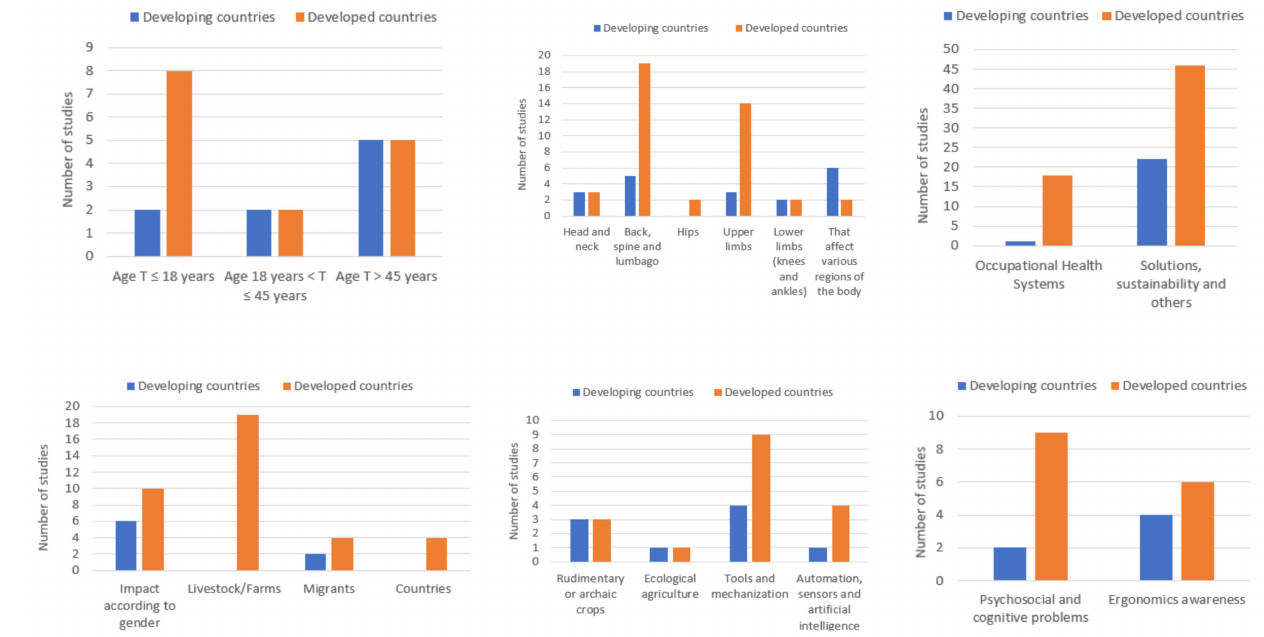
Figure 10. Number of studies according to Tables A1–A19